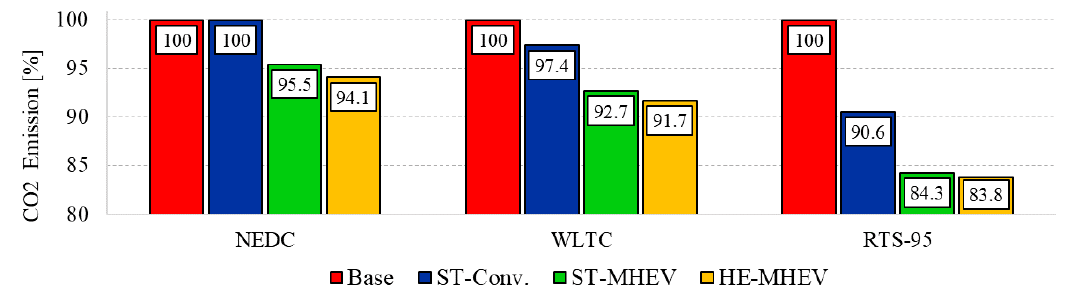
Figure 10. Normalized CO 2 emissions for the NEDC, WLTC and RTS-95.